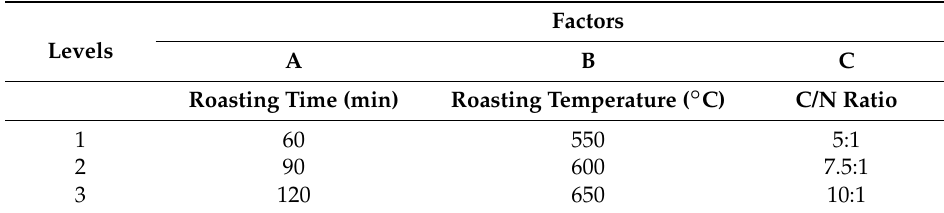
Table 4. Parameters with their levels used in alkaline-roasting activation of copper-mine tailings (ARMT) samples.